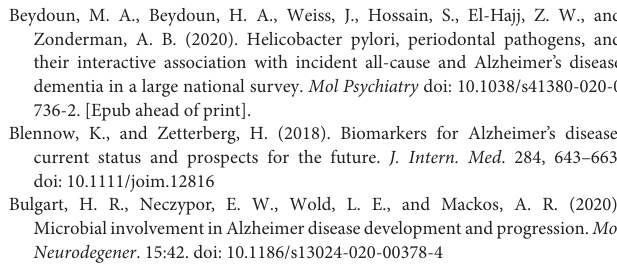
Supplementary Table 2 | Level of family in all groups file. Supplementary Table 3 | Level of species in all groups